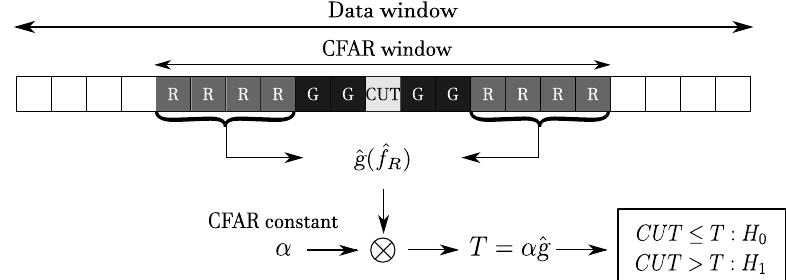
Figure 8. Basic monodimensional Constant False Alarm Rate (CFAR)